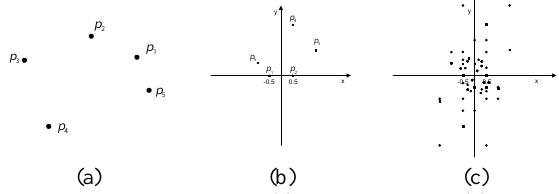
Figure 3. Geometric Hashing (a) the model points, (b) hashing table entries with base pair, (c) all hashing table entries with all base